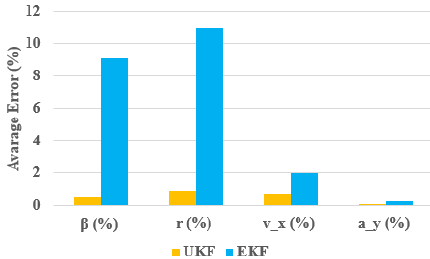
Figure 17. The average error of the proposed UKF-based estima- tion method and traditional